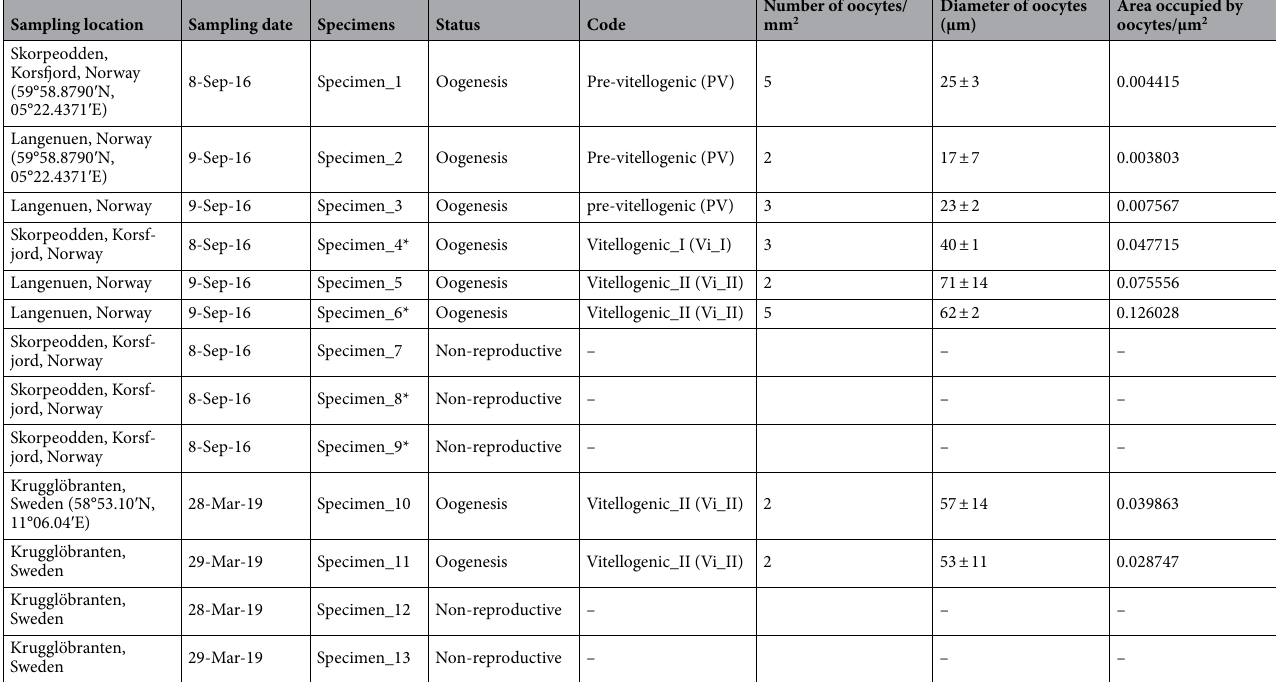
Table 1. Information on the sampling characteristics and the reproductive status of Phakellia ventilabrum specimens studied. The asterisks signal the samples that were also used for the transcriptomic